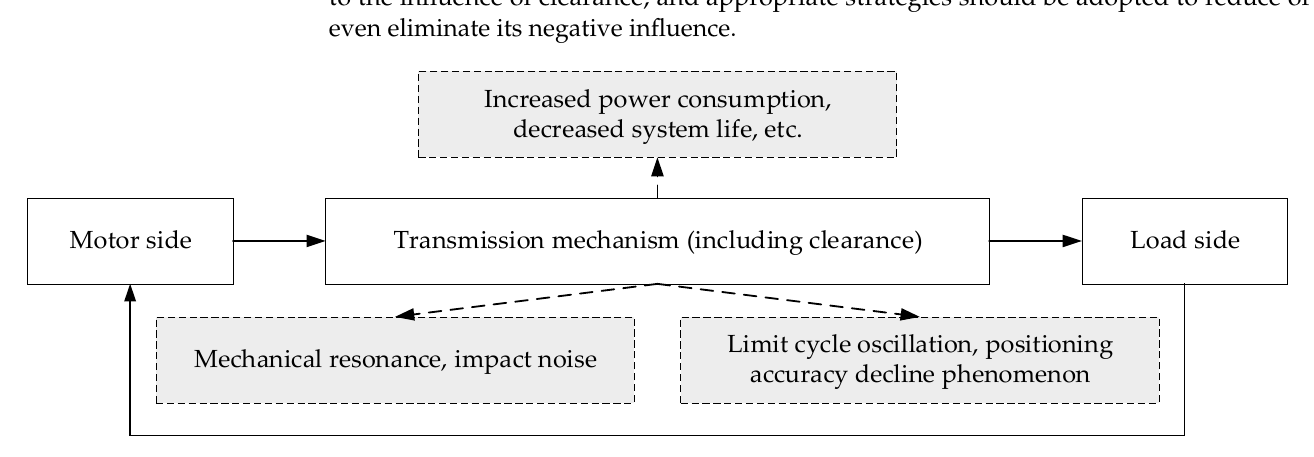
Figure 1. Schematic diagram of the effect of clearance.